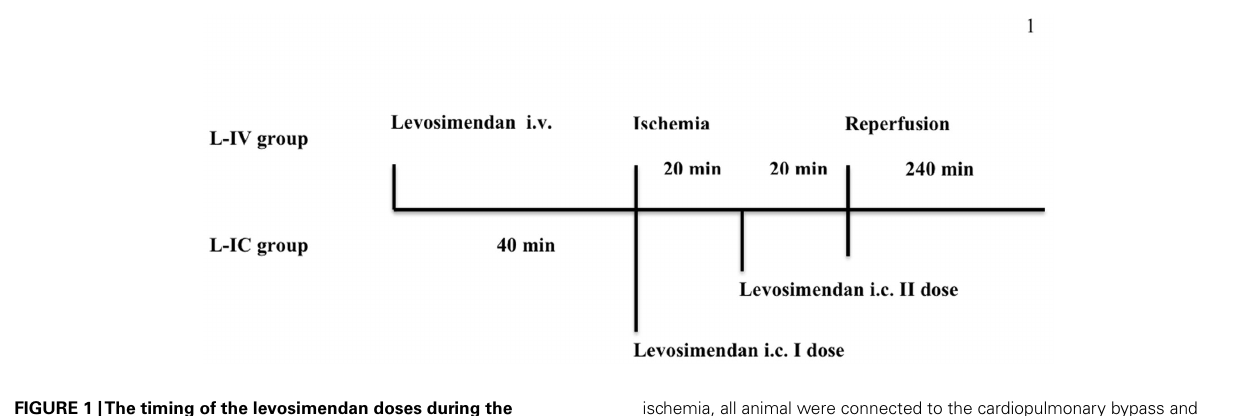
FIGURE 1 |The timing of the levosimendan doses during the experiment. L-IV group = levosimendan (65 μ g/kg) given intravenously before ischemia, L-IC group = levosimendan (65 μ g/kg) given intracoronary during ischemia in two doses (I and II). During